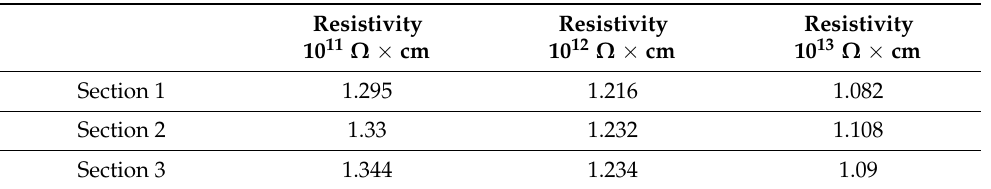
Table 5. Form factor k 1 [-] of the supply voltage form factor, rectified voltage, with a 2 mm on the section surfaces, and for three